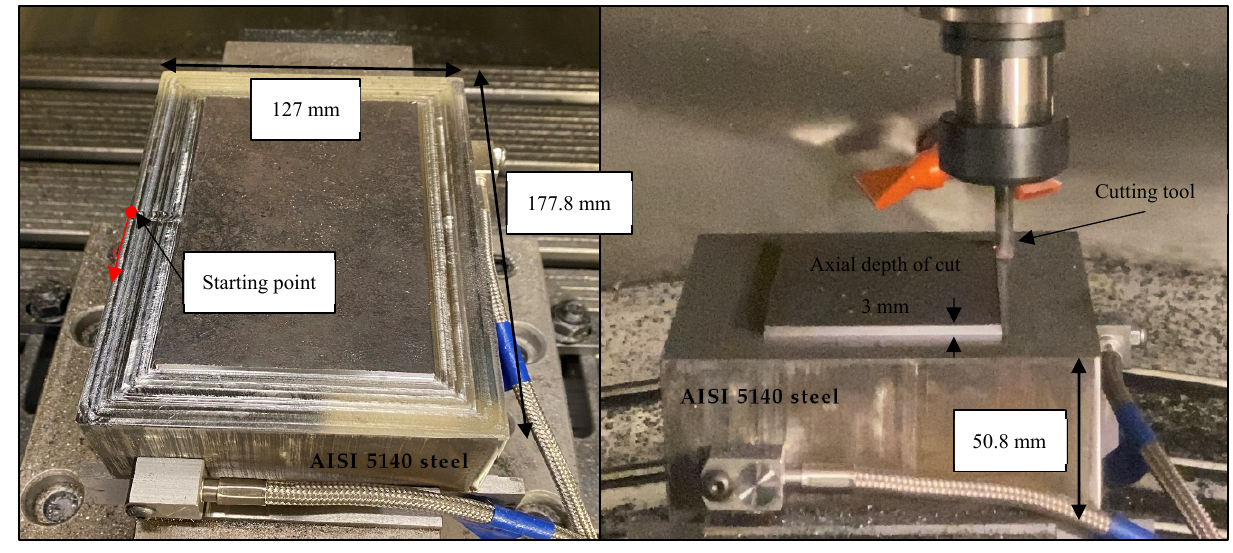
Figure 2. The experimental setup. Table 1. General chemical properties of AISI 5140 steel.